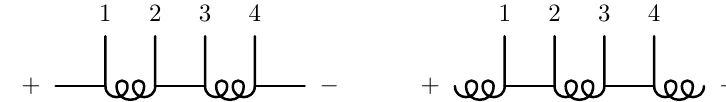
Figure 6 . The half integrand in (4.14) has contributions from forward limits in both scalars and gluons. Typical diagrams from J tree (+ , 1 | 3 , 4 | 2 , − ; ∅ ) and J tree (1 , 2 | 3 , 4; { + , −} ) are depicted YM+ φ 3 YM+ φ 3 in the left and right panel,